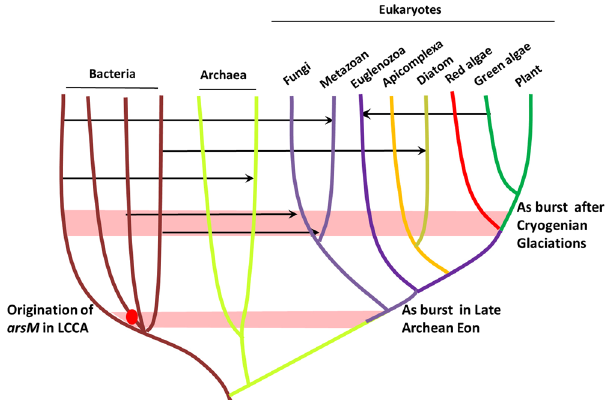
Figure 4. Diagram illustrating the inter-kingdom HGT of arsM gene. Horizontal lines and arrows show HGT donors and recipients. LCCA, last cyanobacterial common ancestor. Information about tree of life is based on Yue et al . 17